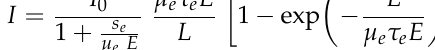
Table 1. Parameters obtained from the analysis of the PC-V data for different photon fluxes according to the Ridzonova et al. model [13]: θ and s e are fitting parameters, N e was determined from the saturation current and µ e τ e was estimated for the lowest photon flux (see